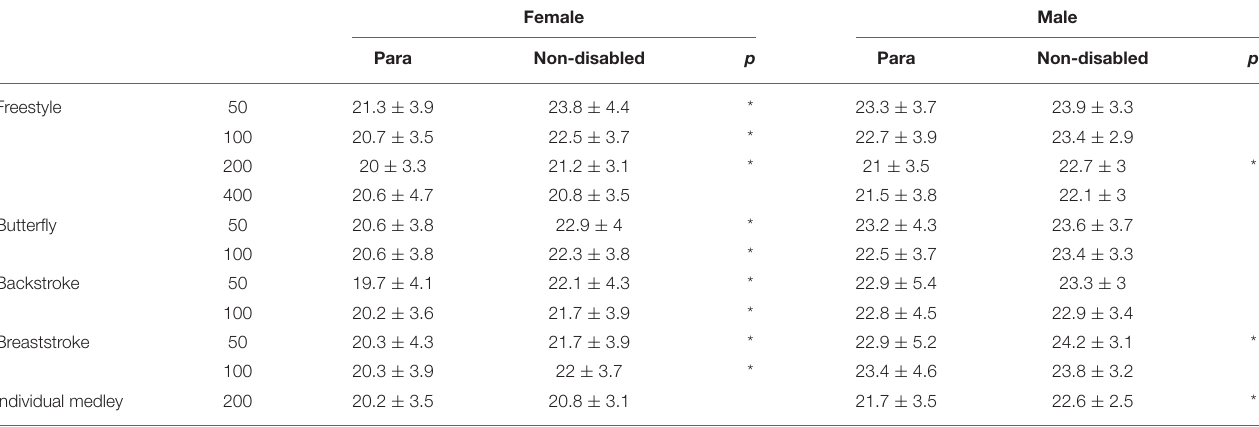
20.2 ± 3.5 * Indicates a significant age difference (p ≤ 0.05) between Para and Non-disabled swimmers for female and male. level of 90.7 ± 2.7%. For female NDS, the performance